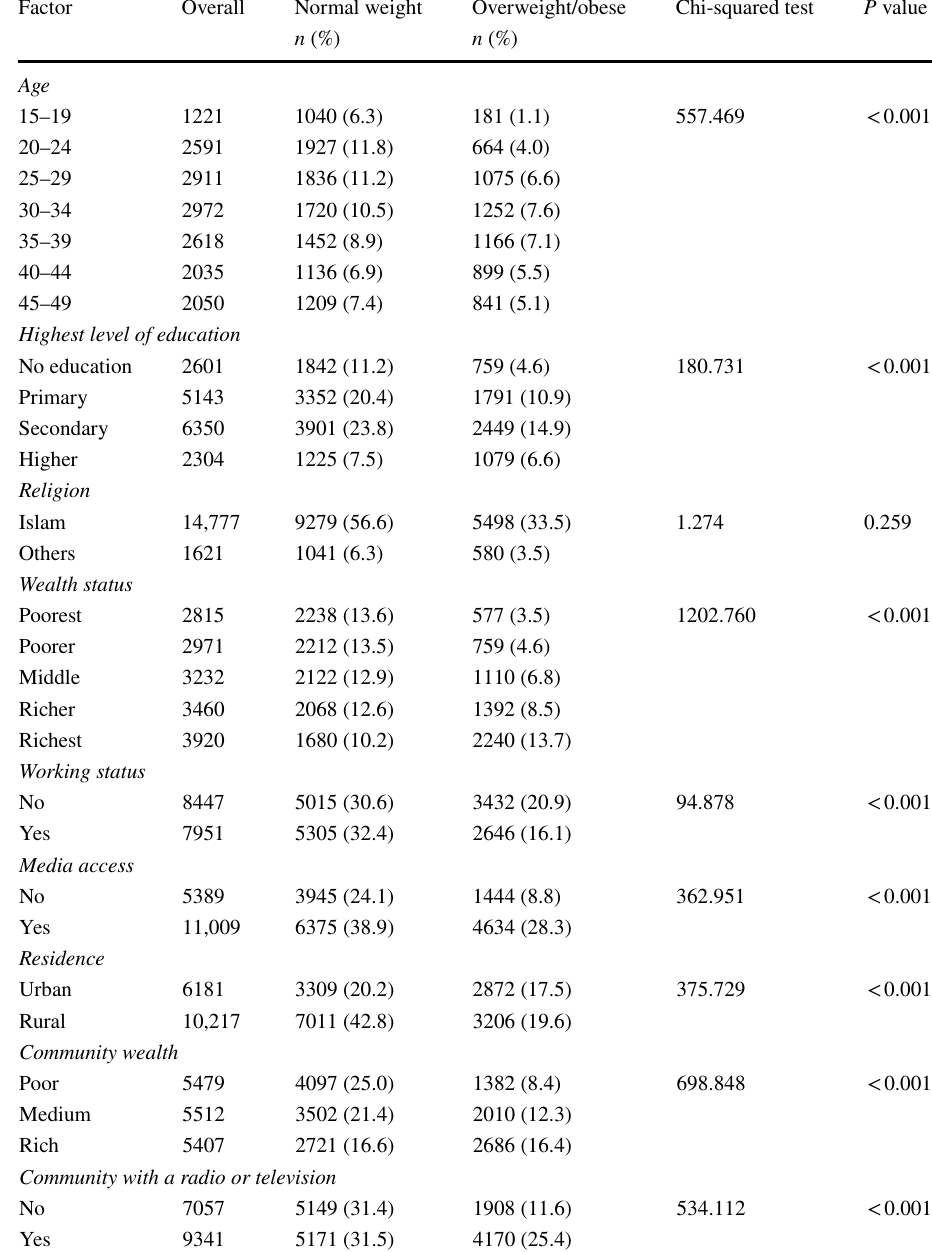
Factor Overall Normal weight